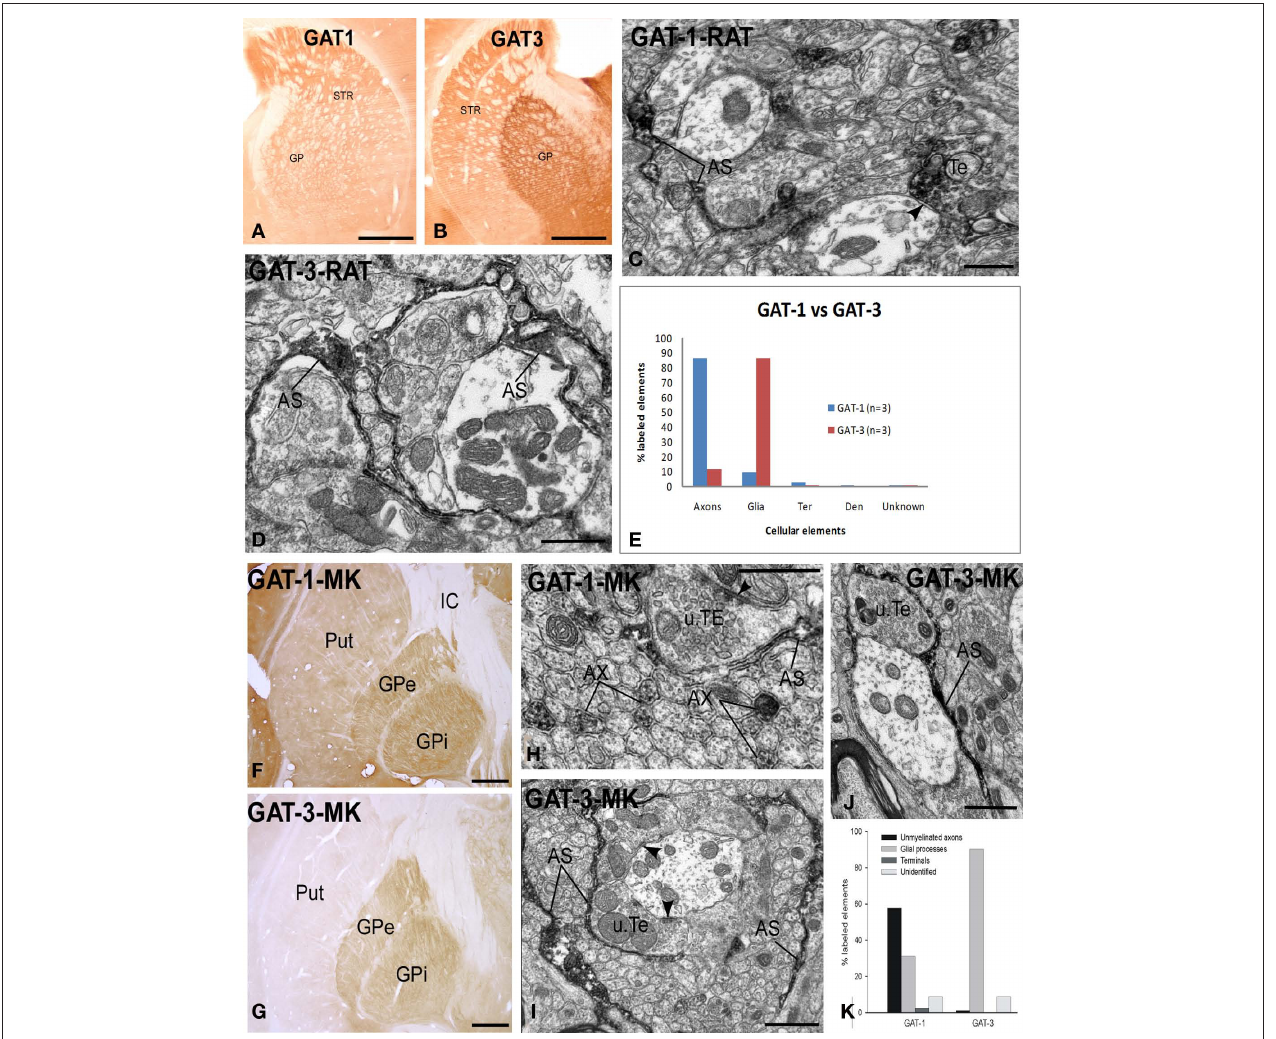
immunoreactivity in the monkey putamen (Put) and globus pallidus (external and internal segments, GPe, GPi). (H) GAT-1-immunoreactive unmyelinated axons (AX) and astrocytic processes (AS) in the monkey GPe. Note that the labeled AS is in close contact with an unlabeled terminal (u.TE) that forms an axo-dendritic symmetric synapse [arrowhead; (i,J) ] GAT-3-positive astrocytes in the monkey GPe (i) and GPi (J) . Note the close association between the immunoreactive AS processes and unlabeled axon terminals forming symmetric synapses [arrowheads in (i) ]. (K) Quantitative distribution of GAT-1 and GAT-3 across different neuronal and glial elements in the monkey GPe and GPi (see Galvan et al., 2005, 2010 for more details). Scale bars: (A,B,F,G) : 1 mm; (C,D,H,i,J) :